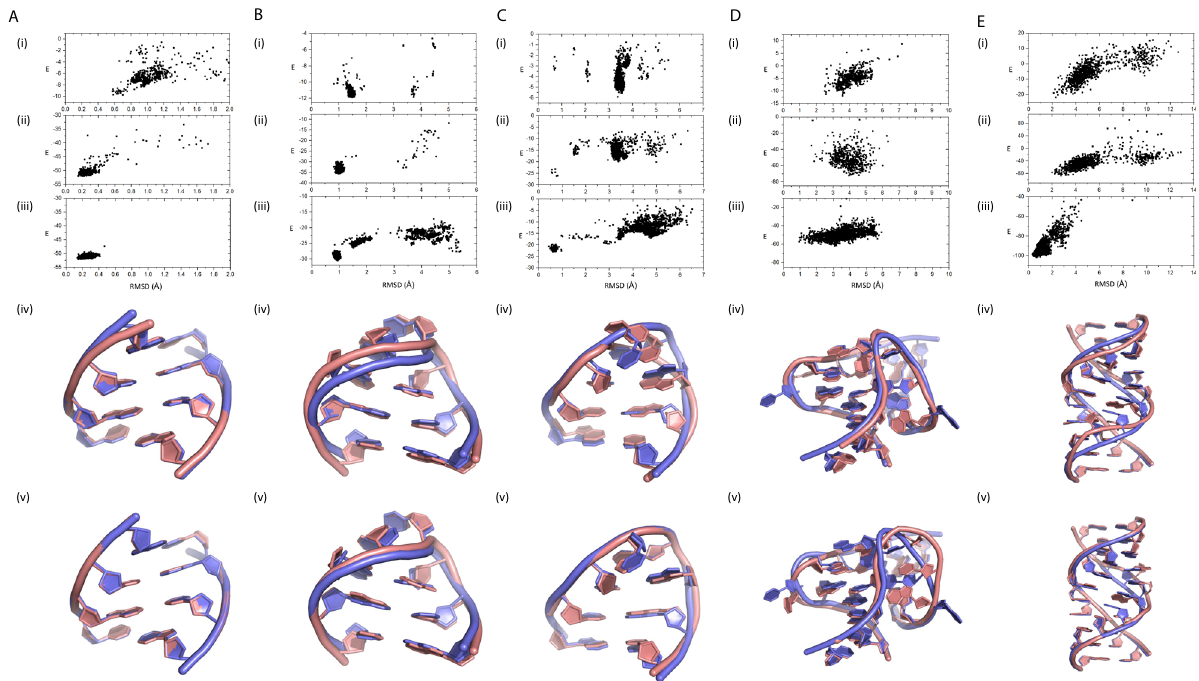
Fig. 3 Comparison of representative motif models from Rosetta-SWM, re fi nement of Rosetta-SWM models and base-pair-restrained prediction by BRiQ. Energy versus RMSD values of the conformations sampled by (i) Rosetta-SWM, (ii) re fi nement of Rosetta-SWM conformations by BRiQ, (iii) structure prediction by BRiQ with all native base pairs fi xed for A CG-helix, B GCAA-tetra loop, C UUCG-tetra loop, D j55a-P4P6- fi xed, and E loopE- fi xed. Structure alignment of native (blue) to the best in top 1% predicted models by Rosetta-SWM (panel iv) and BRiQ re fi nement (panel v) in the bottom